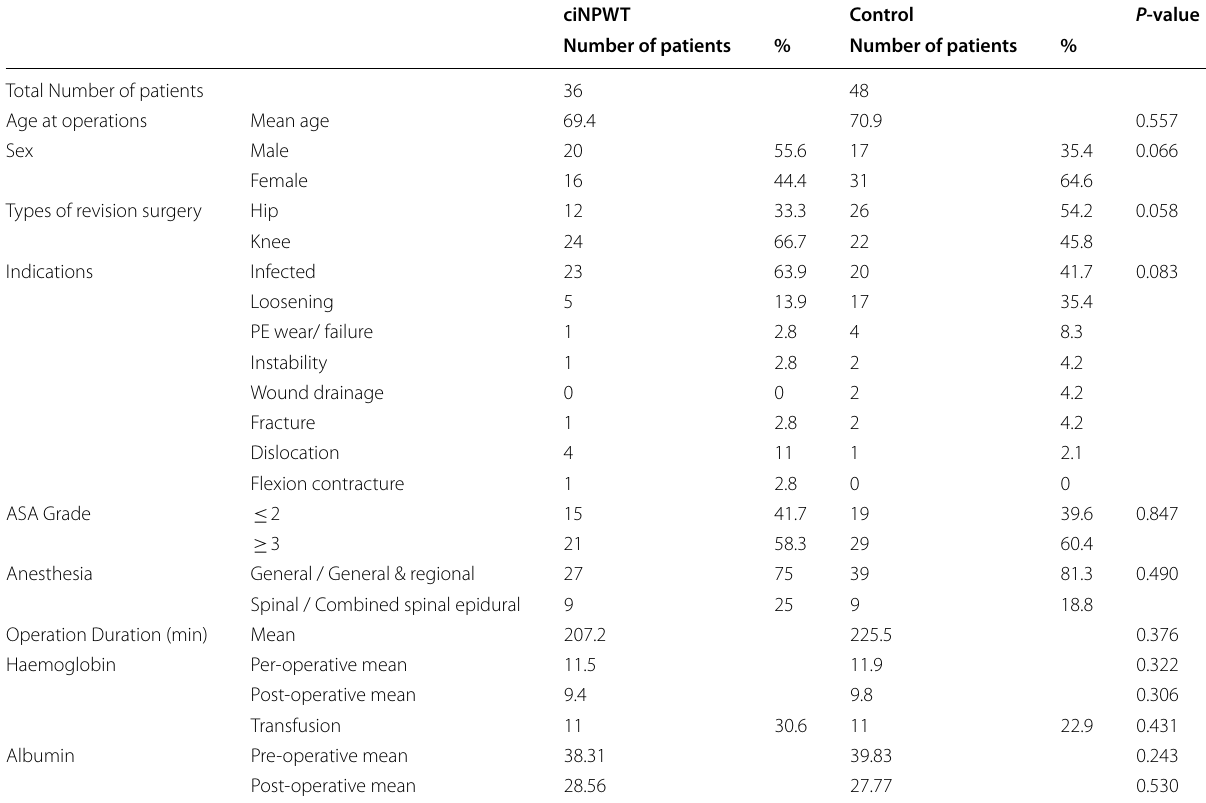
ASA American Society of